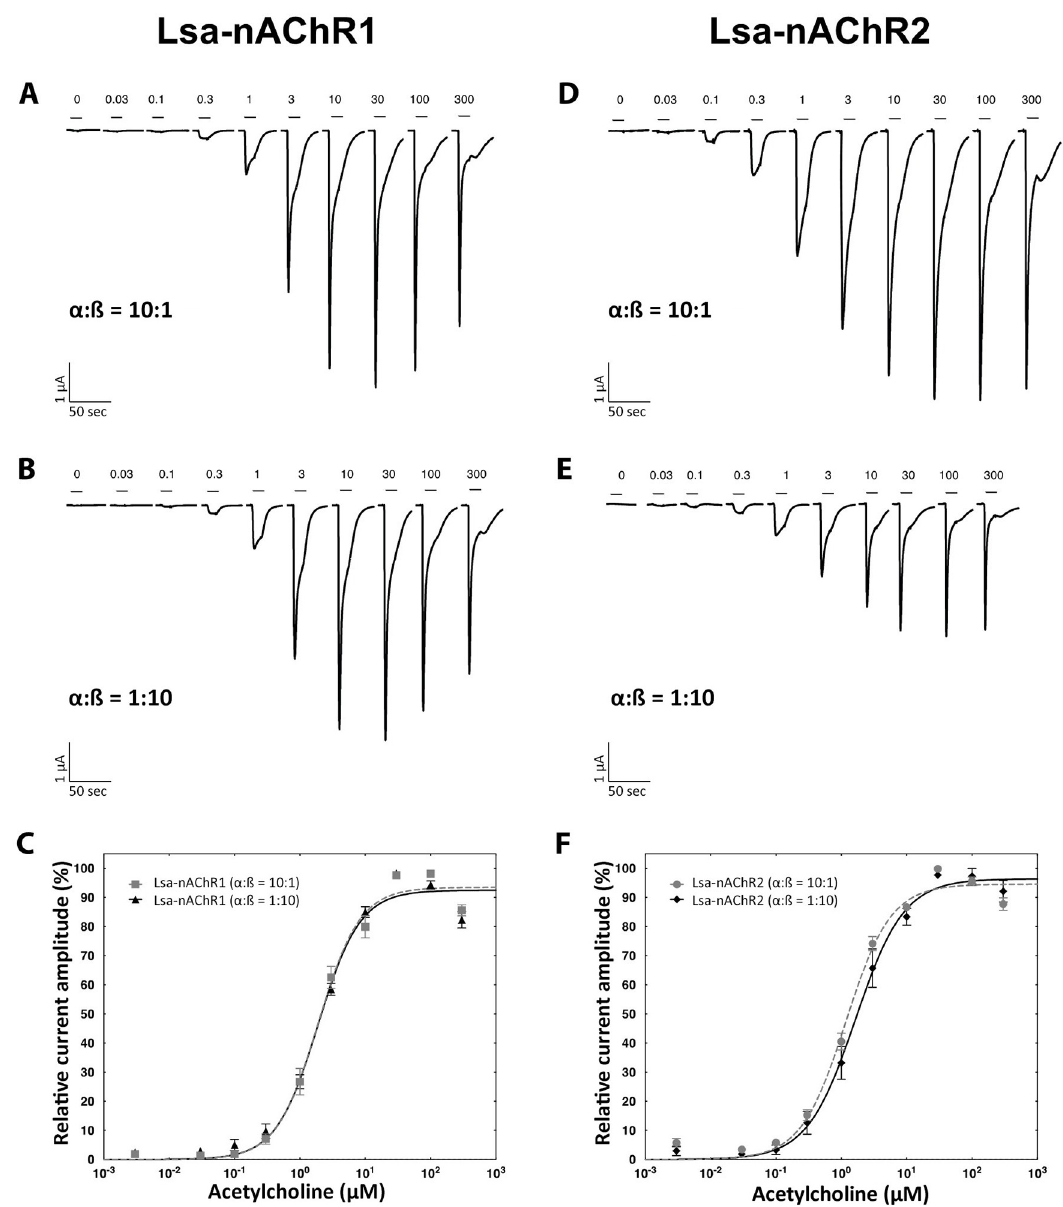
Fig 4. Effect of two different α : β ratio on Lsa-nAChR1 and Lsa-nAChR2 sensitivity to acetylcholine. Typical current traces and averaged dose response curves from a cumulative exposure to increasing dosage of ACh (in μ M) for Lsa-nAChR-1 (A, B and C) and Lsa-nAChR-2 (D, E and F). The α : β ratio used for each experiment is indicated below the traces. Individual curves were standardized to the fitted maximal current amplitude and subsequently averaged. Mean ± SEM of experiments carried out with at least two oocytes from two batches is shown. ( α : β = 10:1) of Lsa-nAChR2 was responsive to sazetidine A, the other was not (Fig 5A and 5C). This indicates that the Lsa-nAChR2 subunits α 3, β 1, and β 2 are able to form two different receptor subtypes with different pharmacological properties, whereas Lsa-nAChR1 could not. Functional heteromeric AChRs, where the structure has been solved, contain at least two alpha subunits (reviewed in Millar 2003 [27]). Both β 1 and β 2 are required in both Lsa-nAChR1 and Lsa-nAChR2 (Fig 2B and 2C), which leaves only one subunit unaccounted for in the